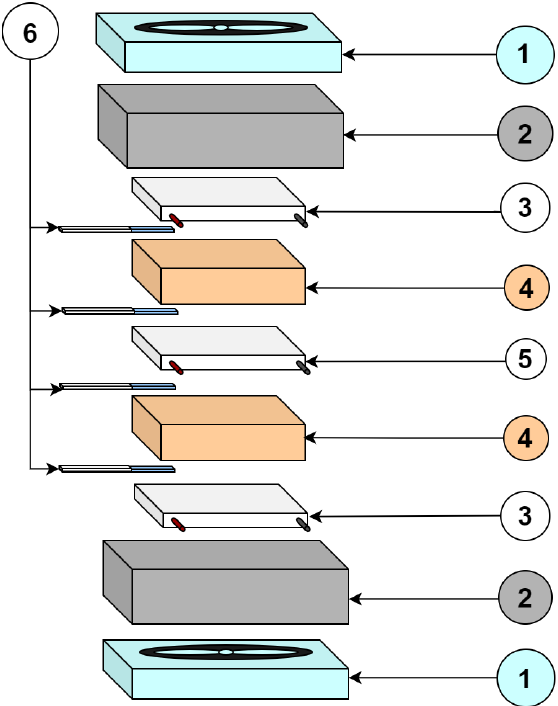
Figure 3. Emulation platform. (1) Fan coolers, (2) heat sinks, (3) thermoelectric coolers (TECs) as coolers, (4) copper blocks, (5) thermoelectric generator (TEG), and (6) thermocouples. Source: c (cid:13) 2020 IEEE. Reprinted, with permission, from IEEE Transactions on Instrumentation and Measurement